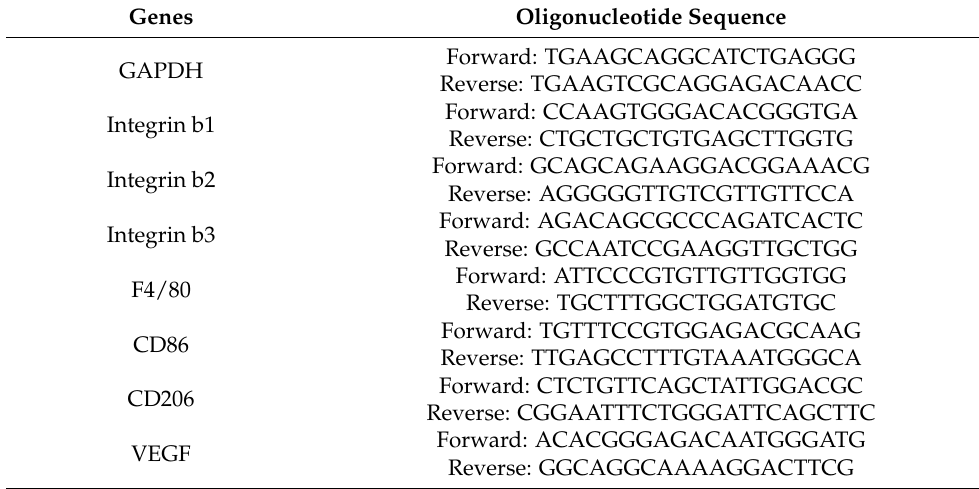
Table 1. Nucleotide primers used for quantitative polymerase chain